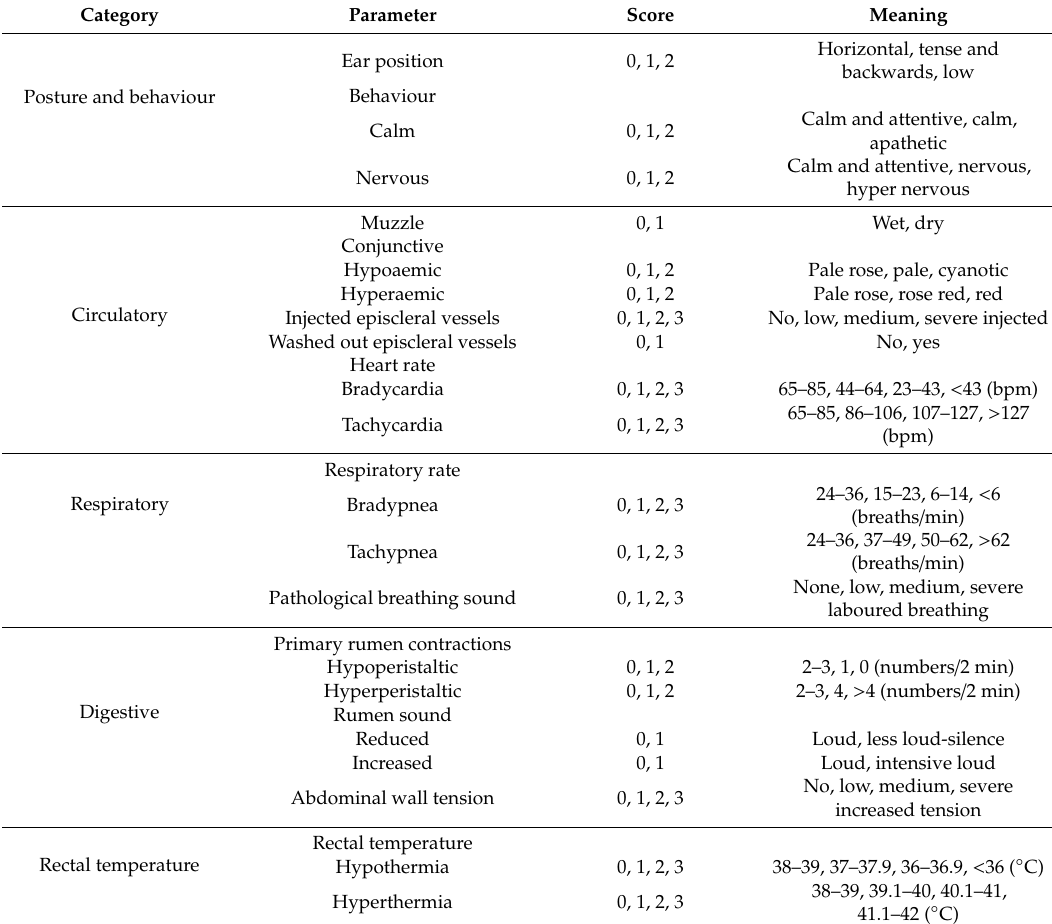
Table A1. Definition of the cumulative clinical score. The physiological level was defined as 0. Clinical findings were assigned to five di ff erent categories. The lines between parameters indicate that only the parameter above or below were considered for the cumulative score. A maximum of 29 points could be reached.